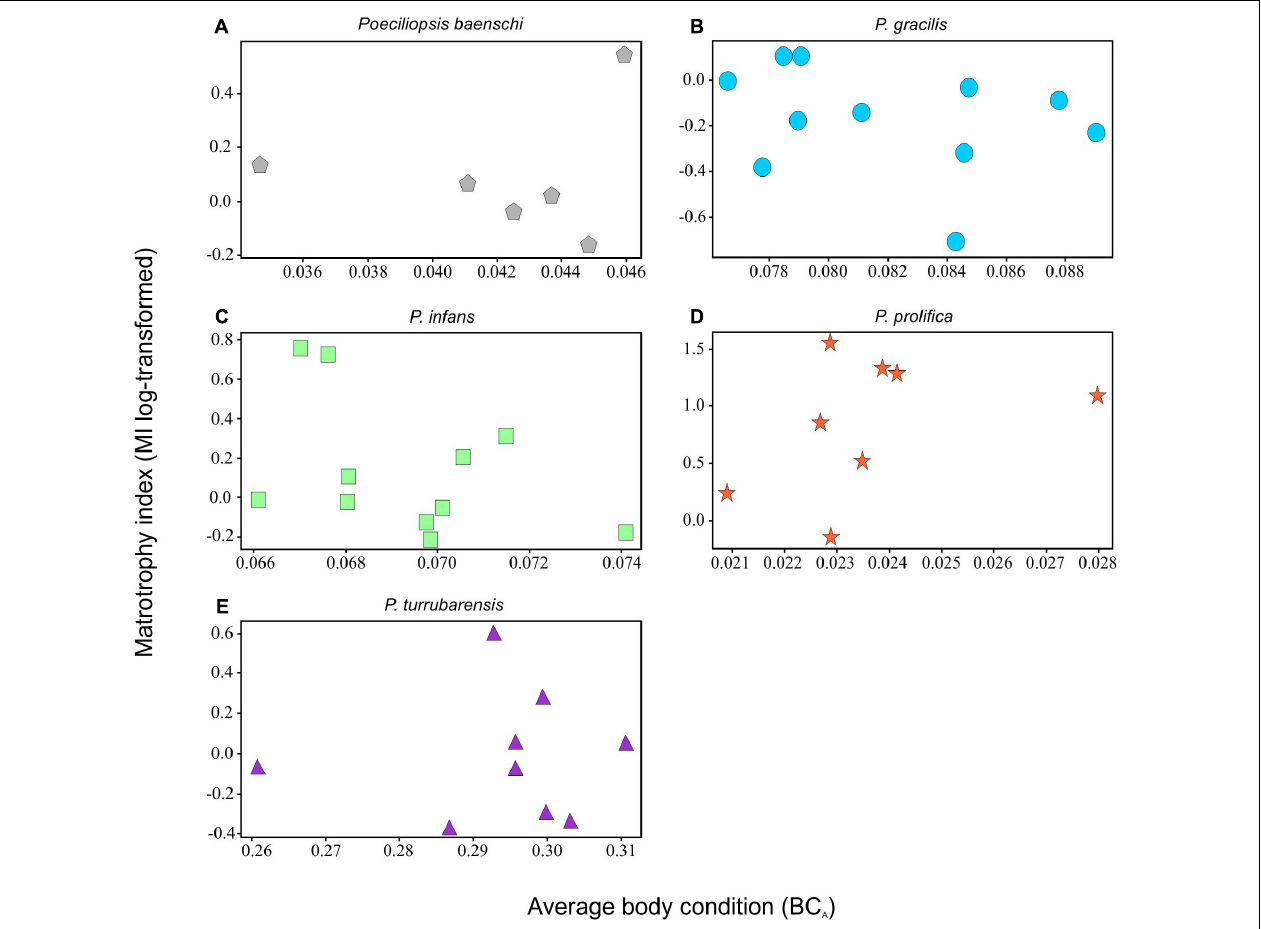
FIGURE 3 | Lack of association between the MI per population and average body condition (BC A ) for 45 populations of five fish species from the genus Poeciliopsis . Each species is shown in a different panel because of substantial differences among species in the values of body condition (BC). Each symbol represents a different species as per ( Figures 1 , 2